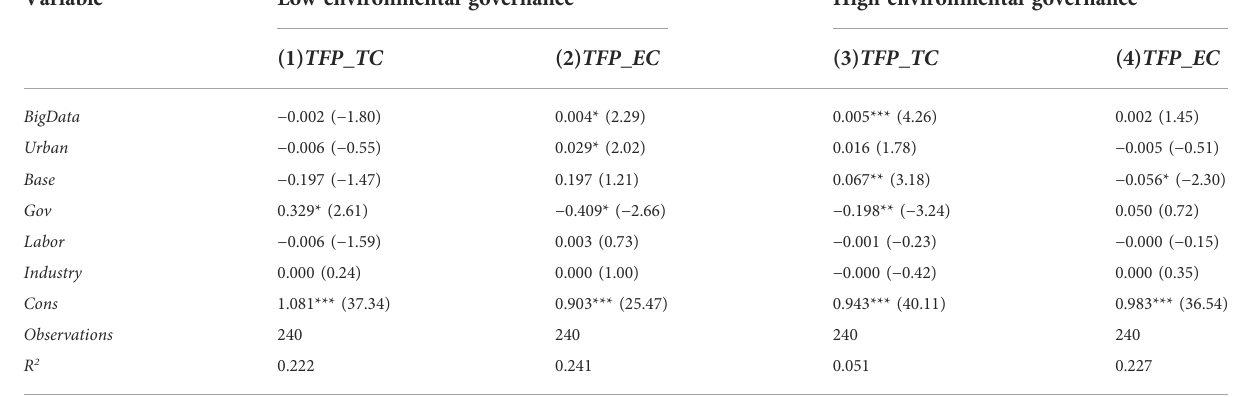
TABLE 6 Empirical results of environmental governance heterogeneity.